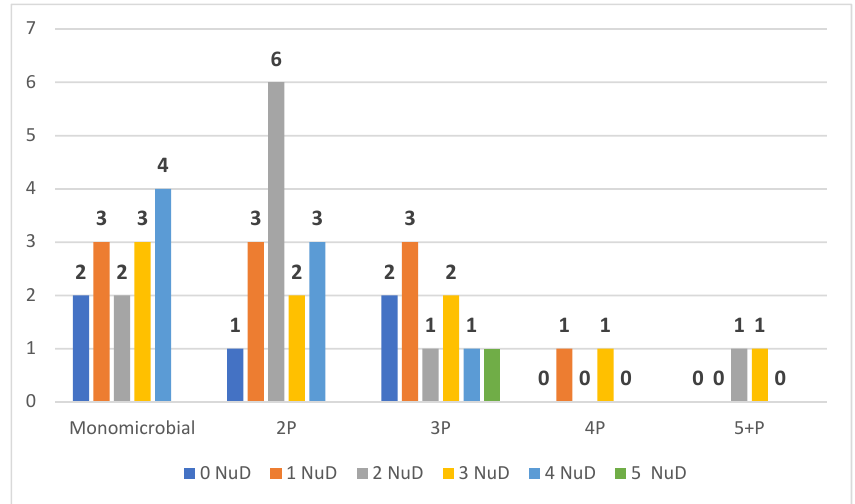
Figure 4. Monomicrobial and polymicrobial infections and DFU patient comorbidities. P2: polymi ‐ crobial infection colonized by 2 microorganisms; P3: polymicrobial infection colonized by 3 micro ‐ organisms; P4: polymicrobial infection colonized by 4 microorganisms; P5+: polymicrobial infection colonized by 5 or more microorganism.